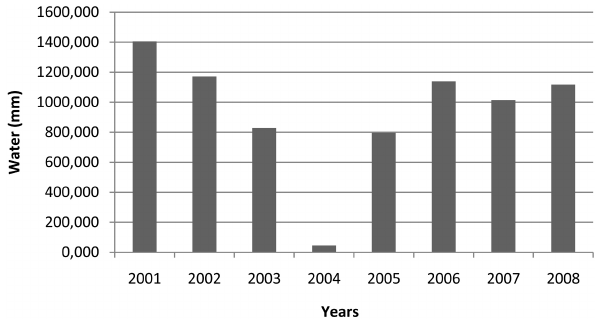
Fig. 5. Snow precipitation at Horcones Weather Station (2001– 2008). Accumulated snow-pillow data in mm of water